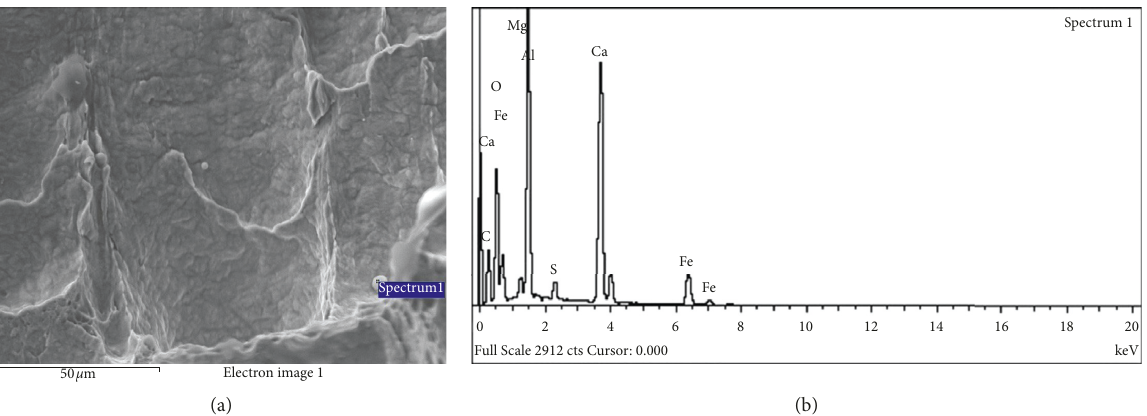
Figure 11: SEM of morphology and composition of inclusions in the fracture zone of the